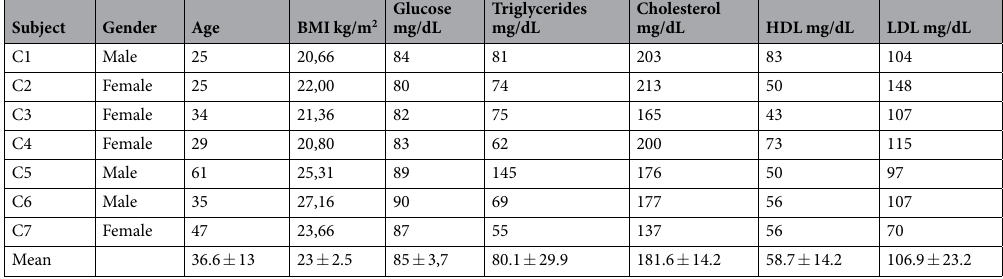
Table 1. Clinical data of the subjects. Abbreviations . BMI: Body mass index, HDL: High density lipoprotein, LDL: low density